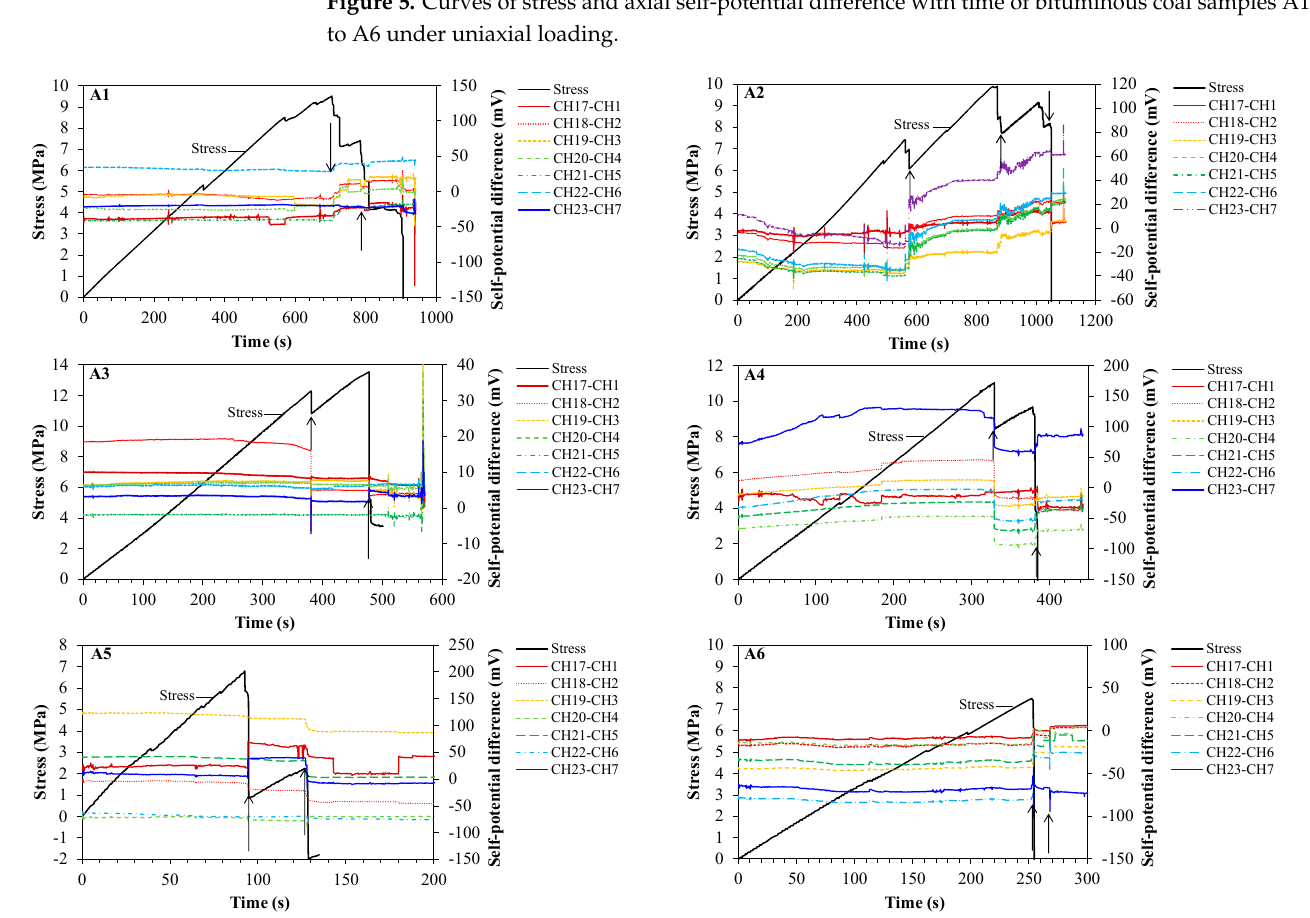
Figure 6. Curves of stress and radial self-potential difference with time of bituminous coal samples A1 to A6 under uniaxial loading.